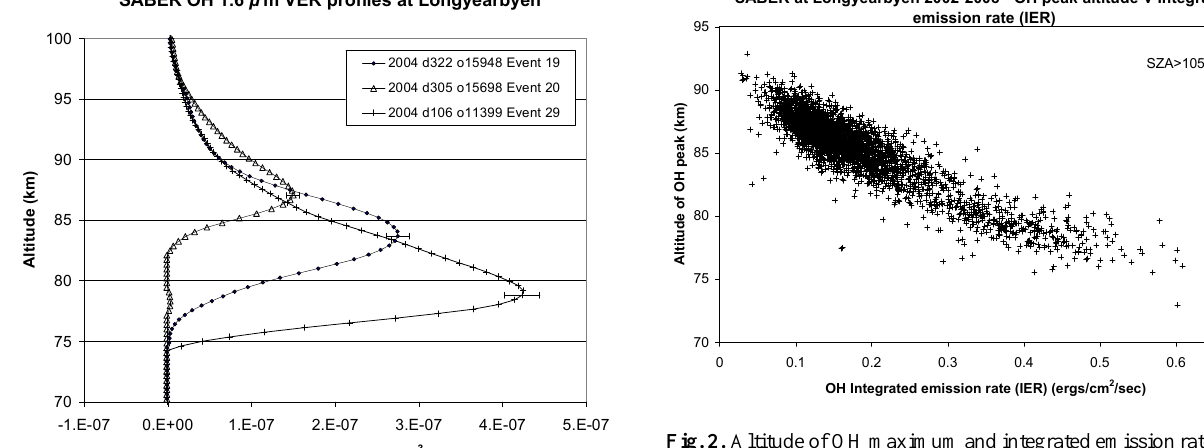
Fig. 2. Altitude of OH maximum and integrated emission rate (IER) for each profile measured by SABER at Longyearbyen (78 ± 5 ◦ N, 16 ± 10 ◦ E) in the period 2002–2008, when the solar zenith angle (SZA) > 105 ◦